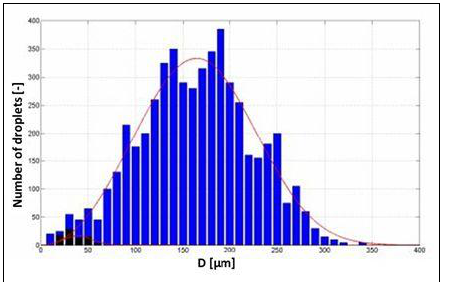
Fig. 2. Example of measured droplets histogram, below (blue) and above (black) eliminator.